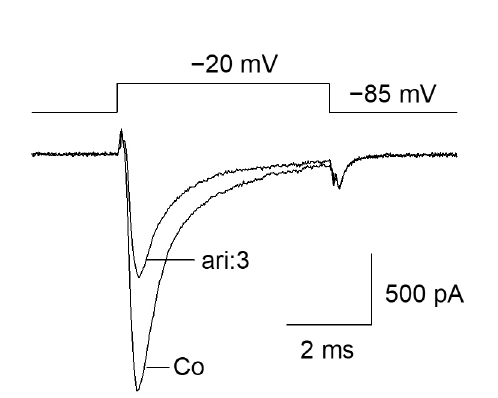
Figure 1. Inhibition of hNa v 1.5 channels by aripiprazole: Representative current traces obtained for control (Co) and in the presence of 3 μ M aripiprazole (ari: 3). Channel activations were carried out by short depolarizations to − 20 mV for 5 ms from a holding potential of − 85 mV.